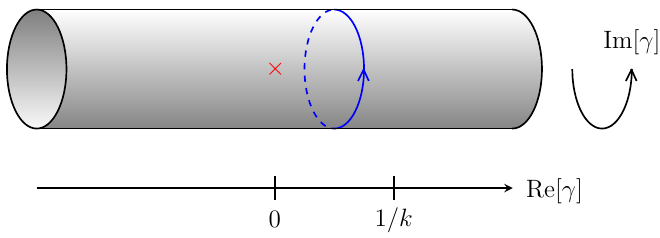
Figure 2 . The characteristic function (cid:13) p ( x ) can be expressed in terms of a closed contour integral running around a cylinder with a circumference of 2 (cid:25) k log p